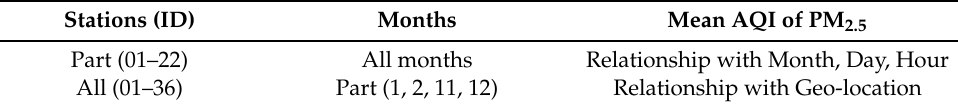
Figure 5. Monthly mean values of PM 2.5 . Colored lines represent days from Monday to Sunday.